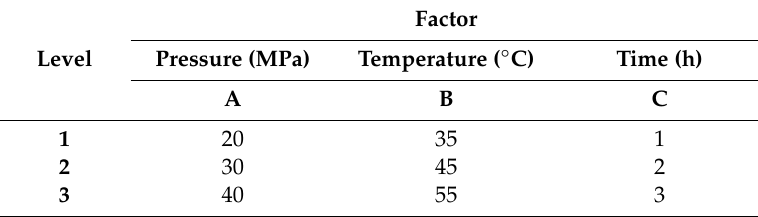
Table 4. Factors and levels for orthogonal experiment design for optimization of SFE extraction process. Factor Level Pressure